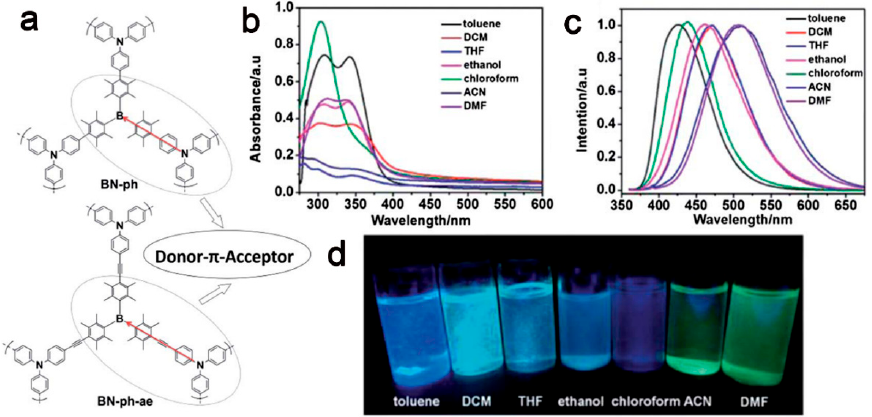
Figure 2. A structural illustration of BN-ph and BN-ph-ae embedding D- π -A units ( a ); normalized UV-VIS absorption spectra ( b ) and fluorescence spectra ( c ) ( λ ex = 350 nm) of BN-ph ; luminescence photographs of BN-ph in different solvents under UV irradiation at λ ex = 365 nm ( d ). Reprinted with permission from [57]. Copyright 2013, The Royal Society of Chemistry.